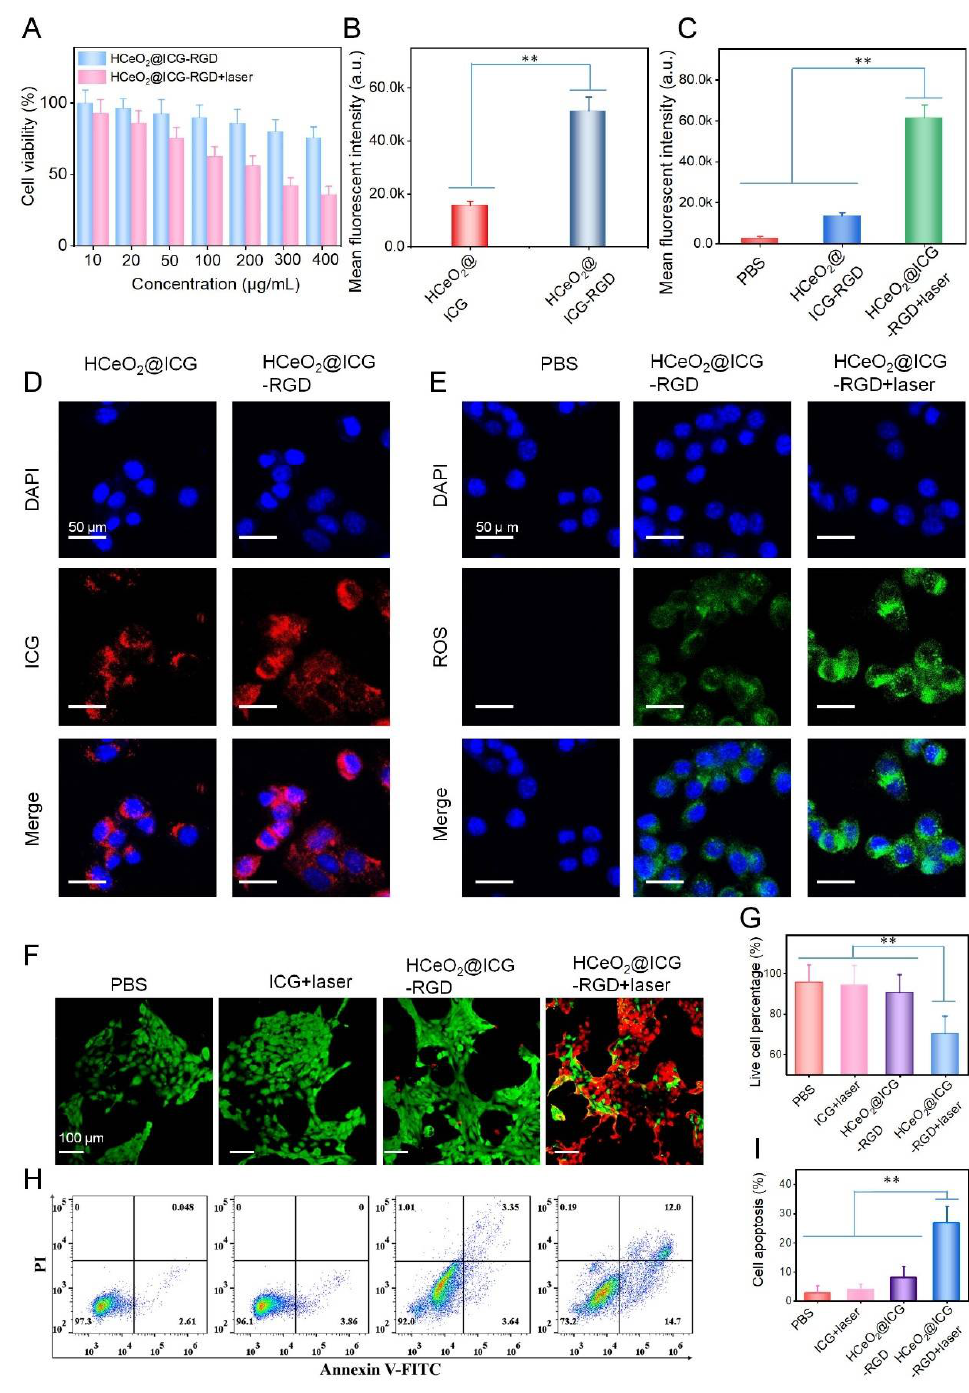
Figure 4. ( A ) Cell viability of 4T1 cells after 12 h of treatment with HCeO 2 @ICG-RGD and HCeO 2 @ICG-RGD+laser (808 nm, 0.75 W cm −2 , 5 min) at various concentrations. ( B , C ) Quantitative fluorescent intensity analysis of CLSM images in ( D , E ), respectively. ( D ) CLSM images of 4T1 cells after treatment with HCeO 2 @ICG or HCeO 2 @ICG-RGD for 12 h. ( E ) CLSM images of intracellular ROS generation after treatment with PBS, HCeO 2 @ICG-RGD, and HCeO 2 @ICG-RGD+laser for 12 h. Fluorescent images of live/dead cells ( F ) and flow cytometer analysis of cell apoptosis ( H ) after treatment with PBS, ICG+laser, HCeO 2 @ICG-RGD, and HCeO 2 @ICG-RGD+laser for 6 h. ( G , I ) Quantitative analysis of total live cells in ( F ) and cell apoptosis in ( H ), respectively. Mean ± SD for n = 4 (** p < 0.01 versus HCeO 2 @ICG-RGD+laser, two-sided Student’s t